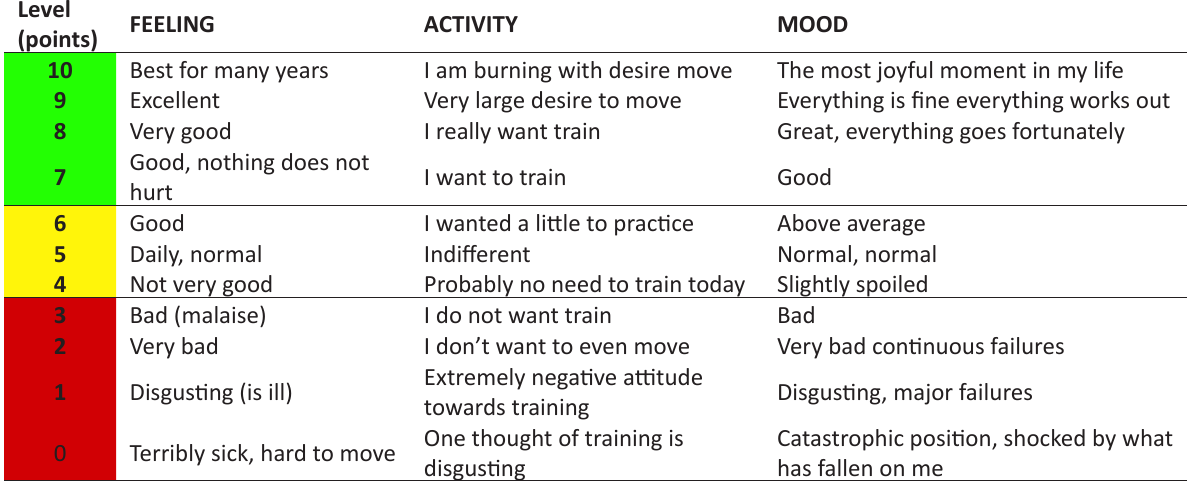
Table 2. Scale-questionnaire «Express-FAM» to clarify the current functional state of those involved